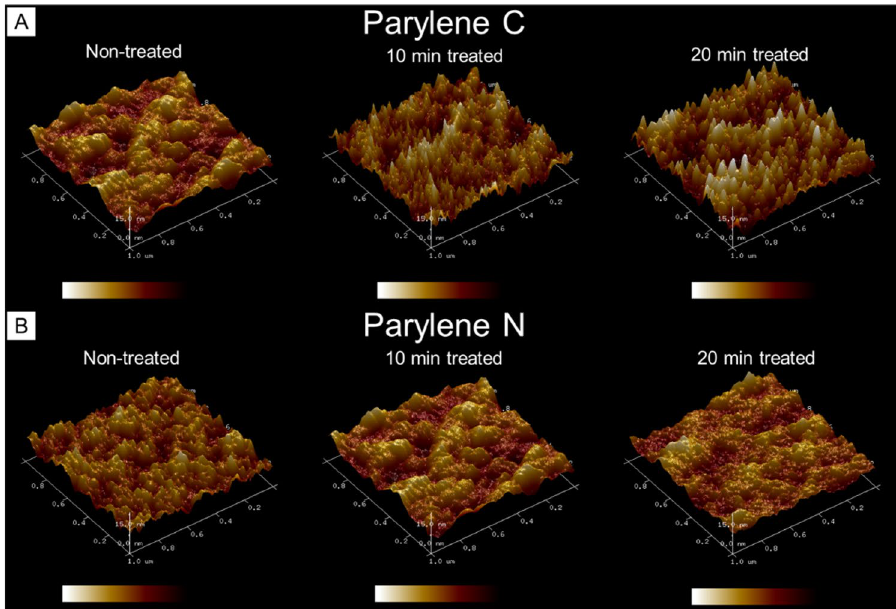
Figure 8. The effect of surface plasma modification of different lengths of time on surface topography and roughness. AFM images of Parylene C and Parylene N surfaces demonstrated slight increases in introduced surface area and roughness on plasma-treated Parylene C as the treatment time increased. Noticeable changes were not observed in plasma-treated Parylene N. The X–Y (0–1 µm) and Z-axes (0–15 nm), as well as the intensity mapping, are all set to the same scale in each AFM